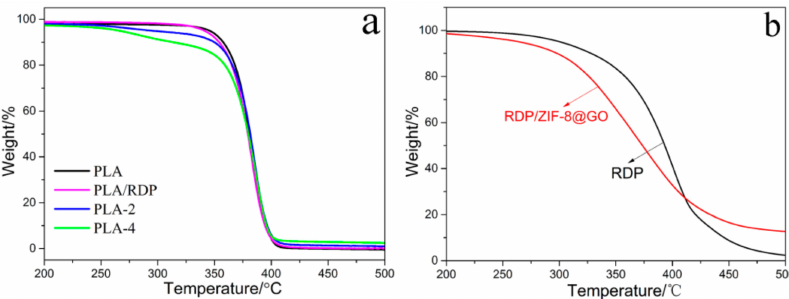
Figure 5. TG curves of PLA nanocomposite films ( a ); RDP and RDP/ZIF-8@GO blend ( b ).